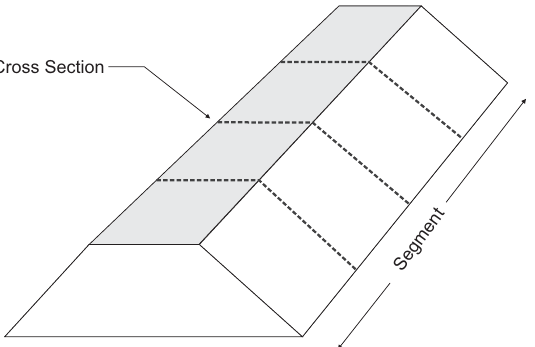
Figure 6. Example of a levee segment whose spatial variability is represented by three cross sections.